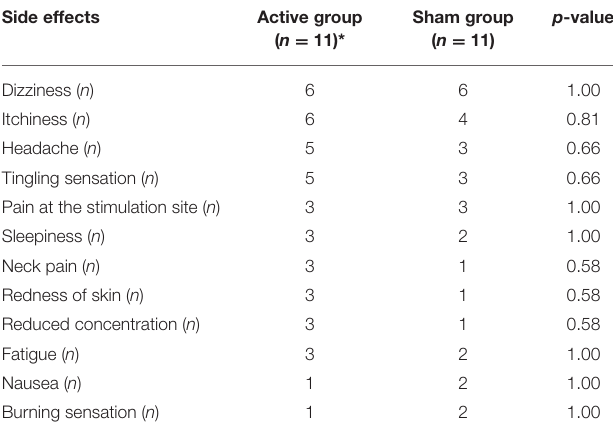
TABLE 4 | Reported side effects between treatment groups.